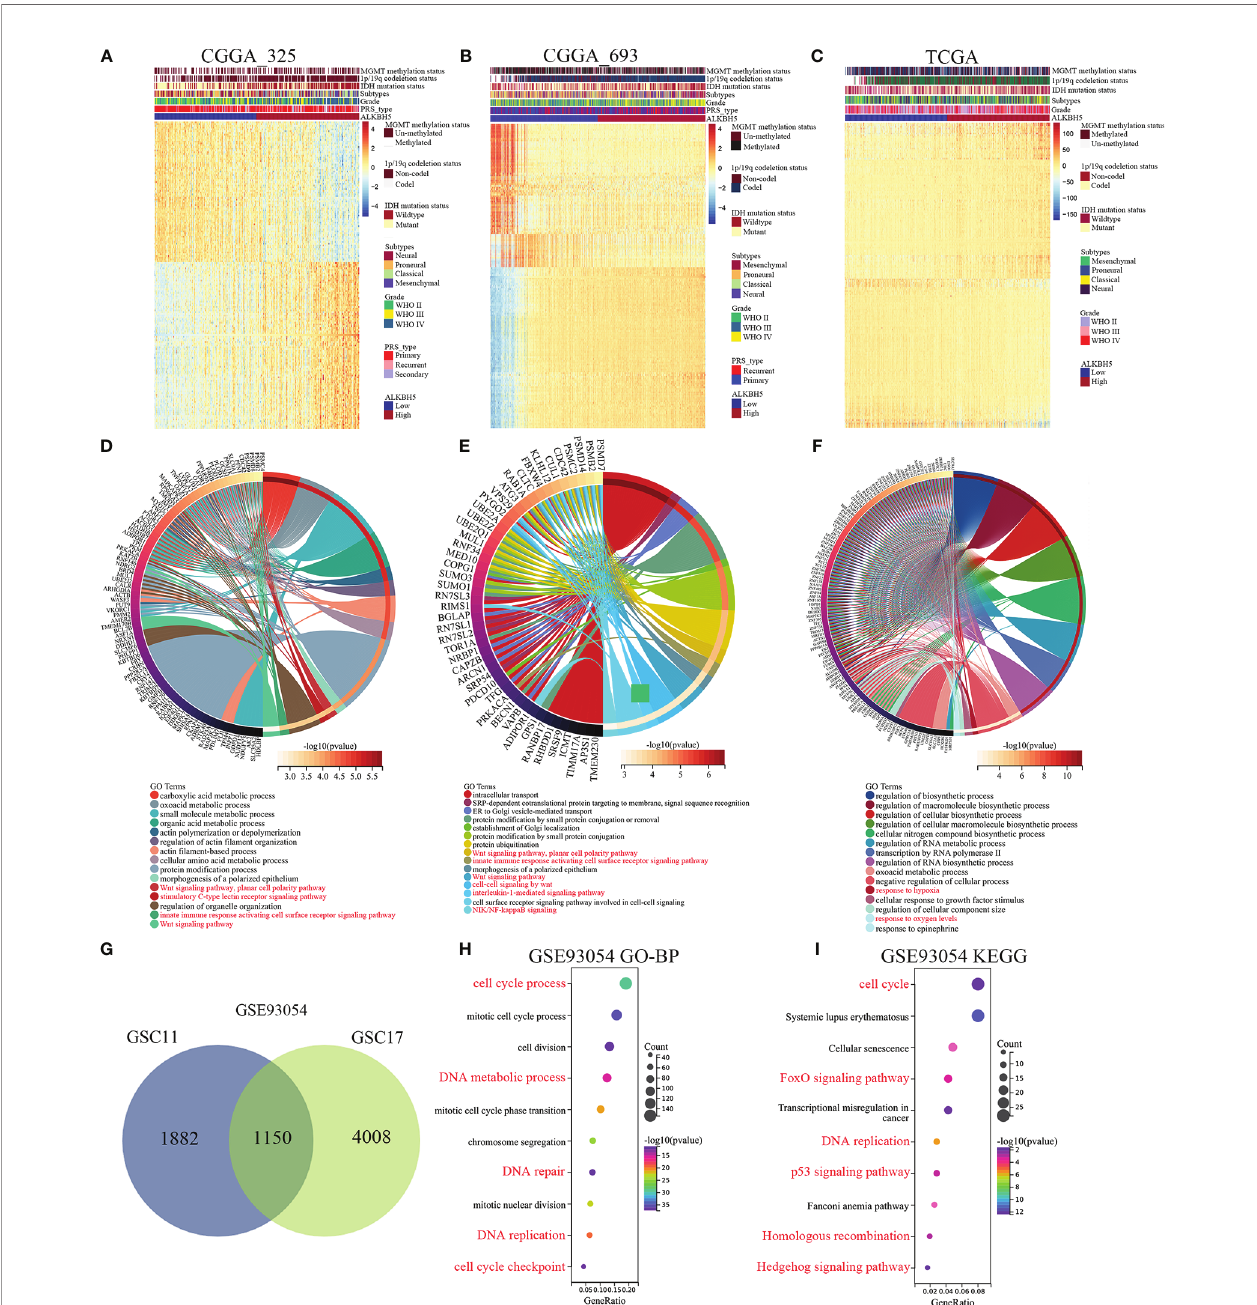
FIGURE 5 | ALKBH5-related genes enrichment analysis in glioma by CGGA_325, CGGA_693 and TCGA datasets. (A-C) Heatmap showing the enrichment patterns of the top 200 genes positively (100) or negatively (100) correlated with ALKBH5 expression of glioma in the CGGA_325, CGGA_693 and TCGA databases. (D-F) Alterations in different classi fi cations of biological functions in gliomas samples with ALKBH5 expression in the CGGA_325, CGGA_693 and TCGA databases. (G) Venn diagram showing the 1150 intersectional genes of differentially expressed genes in GSC11 (3032 differentially expressed genes) and GSC17 (5158 differentially expressed genes) cell lines after ALKBH5 knockdown in GSE93054 dataset. The GO-BP (H) and KEGG (I) pathway enrichment analyses were applied with the 1150 intersectional genes of differentially expressed genes in GSE93054 dataset. Red label indicated that these GO-BP or KEGG analysis was associated with cell cycle, DNA damage repair, metabolism, or